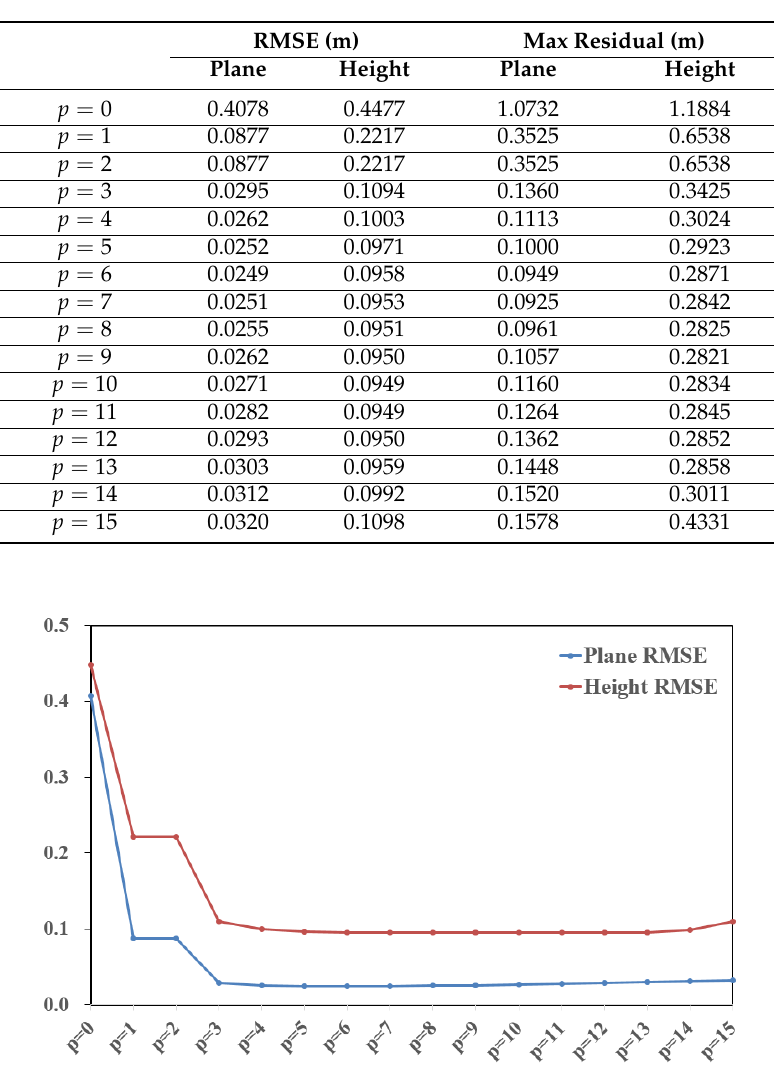
Table 6. The RMSE and max residual of the plane and height directions as a function of the parameters in the exponential kernel function.